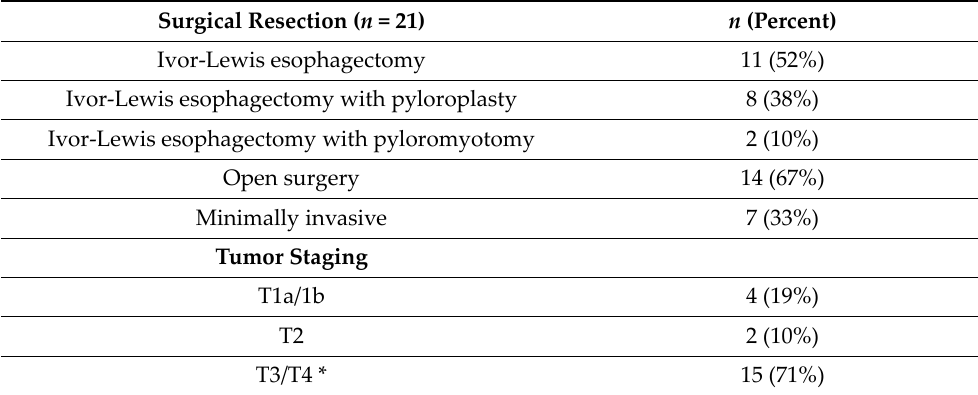
Table 2. Surgical characteristics of study